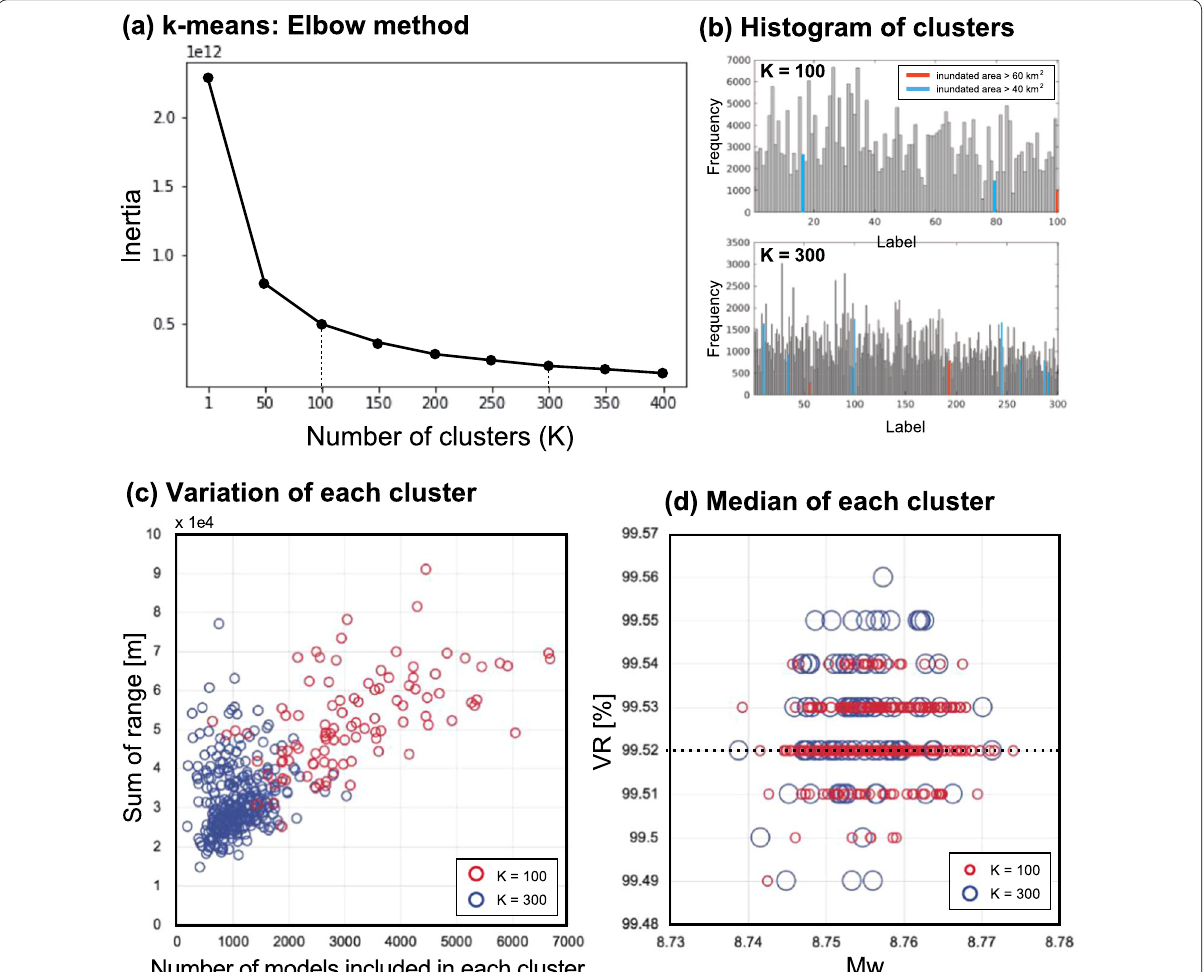
Fig. 9 Clustering using k-means with the slip vector as the feature value. A Elbow method when the number of clusters is changed. b Frequency distribution of each cluster when K 100 and K 300. Red and light blue bins indicate clusters with inundation areas of 60 km 2 or more, and 40 to = = 60 km 2 , respectively. c Correlation between the number of models included in each cluster and the variation of the slip distribution, which is the scalar value obtained by adding the slip ranges of all perturbation faults for each cluster. d Correlation between Mw and variance reduction (VR) of the median model (tsunami scenario) of each cluster. The dotted black line indicates the original VR of all clustered